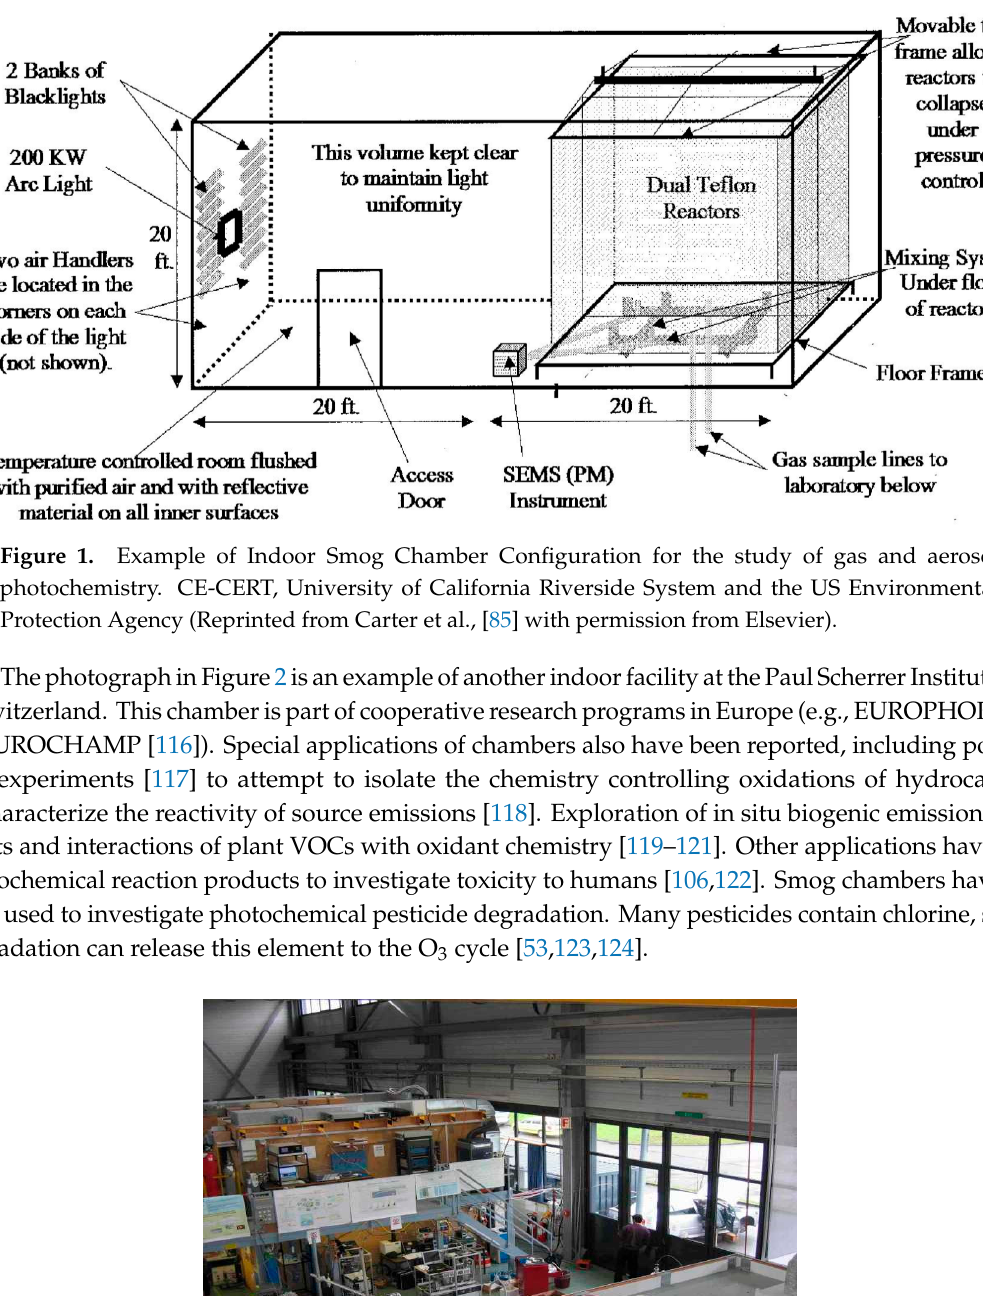
Figure 2. Photograph of the Indoor Smog Chamber at the Paul Scherrer Institute (Copyright Paul Scherrer Institute).